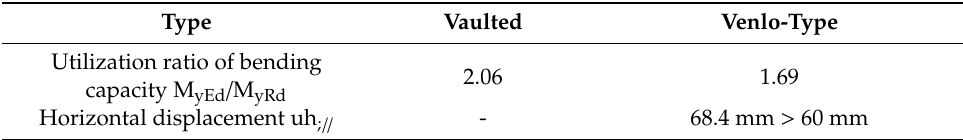
Figure 16. The ratio of design bending moment to design bending resistance of the cross-section, M yed / M yRd , of columns of Venlo-type greenhouse. Table 8. Design inadequacies of the two